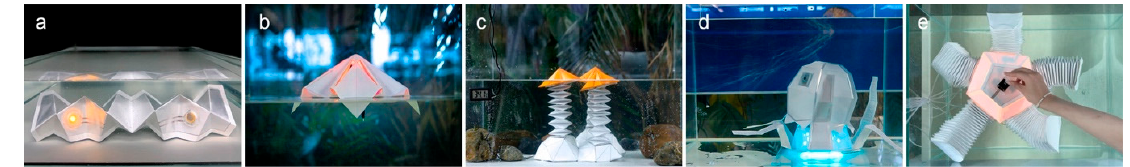
Figure 1. ( a ) Waterproof, foldable paper-based electronic interface of ElectroPaper system. Example applications: ( b ) a paper device to detect water quality; ( c ) a decorative device that floats according to the water temperature; ( d ) a camouflaged camera to capture underwater scenes; and, ( e ) a deformable robot for entertaining interaction.